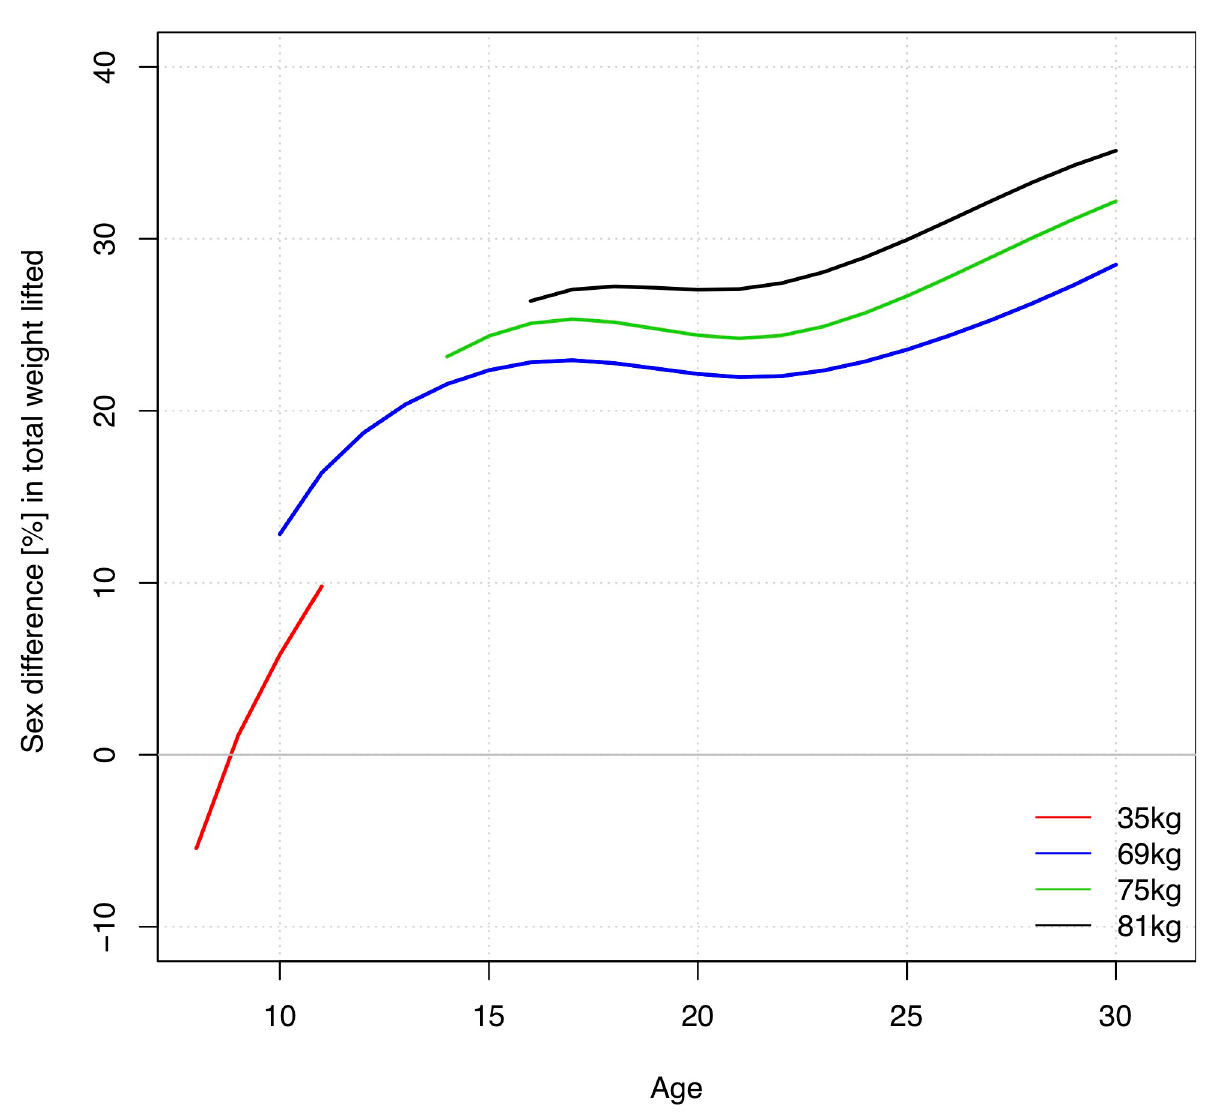
Fig 5. Sex differences in percent in total weight lifted for different body mass and ages at the 90 th percentile. https://doi.org/10.1371/journal.pone.0238369.g005 more body mass in order to maximize the total weight lifted. A larger proportion of youth weightlifters can be expected to be heavier than controls of the same age in the general popula- tion. For example, for 14 to 20 year olds 33% male and 17% female weightlifters were heavier Table 4. Age at peak performance for USA athletes and athletes at IWF world championships and Olympics � at the 90 th and 50 th